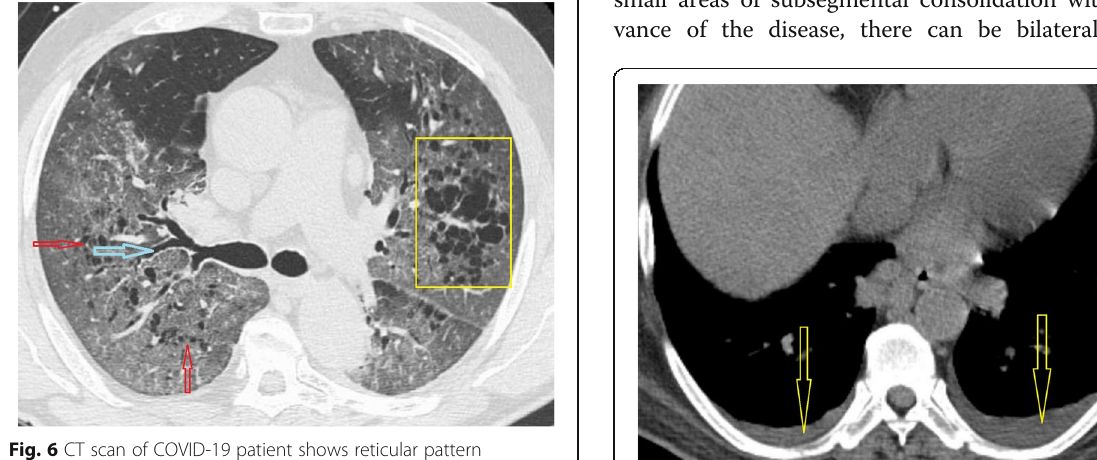
box). Bronchiolar irregularity at right lower lobe (blue arrow)